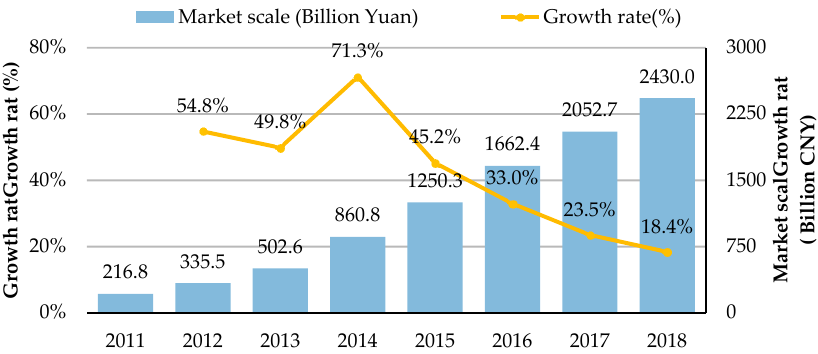
Figure 1. Chinese market scale of online catering takeaway from 2011 to 2018 (Data source: the analysis report on big data of Chinese catering takeaway in 2018 released by Chenzhi Technology [1]).